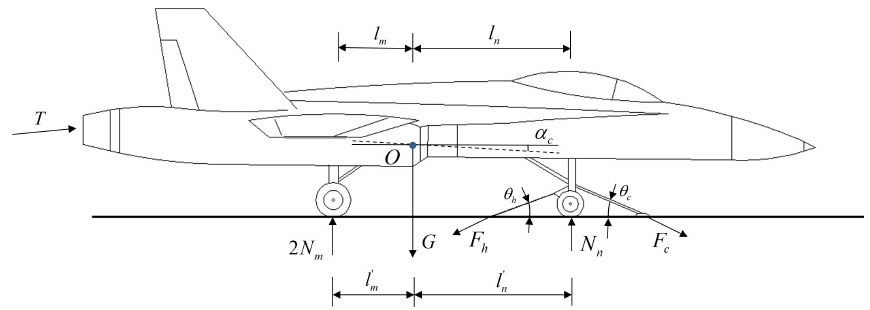
Figure 1. Aircraft force analysis in holdback bar tension